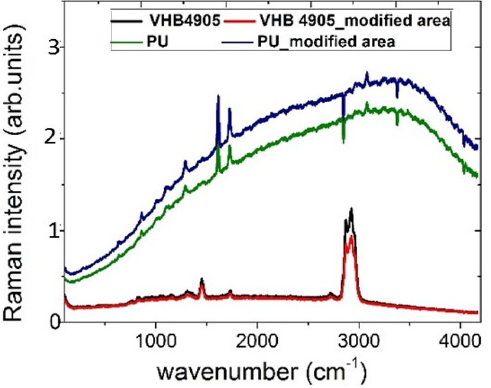
Figure 10. Raman spectra acquired in the non-modi fi ed and modi fi ed (inscribed di ff raction grating) regions inside VHB 4905 elastomer and PU thermoplastic polymer at the 532 nm laser excitation.